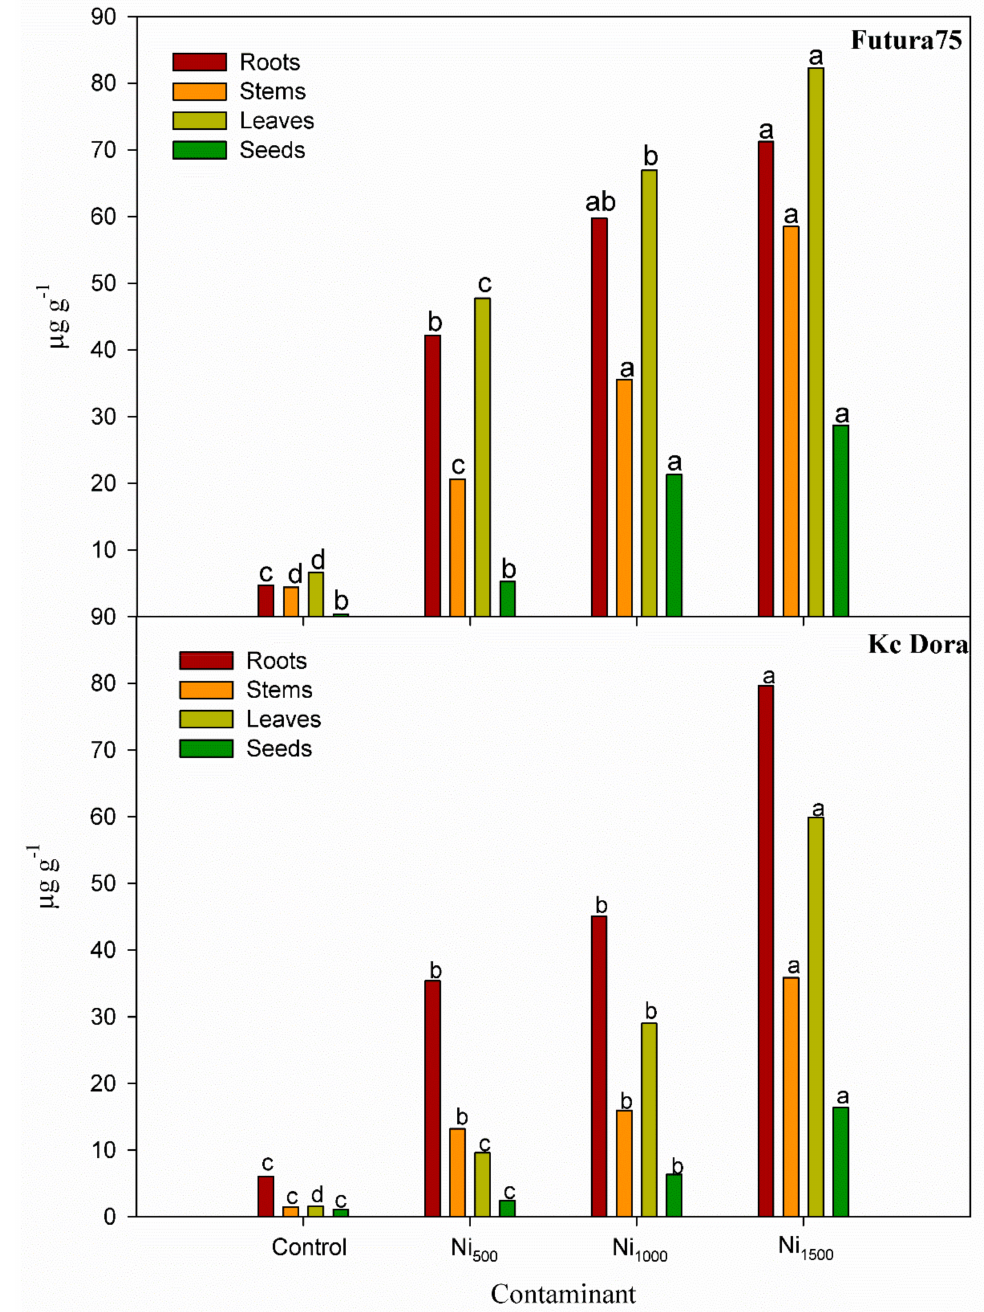
Figure 3. Concentration of nickel ( µ g g − 1 ) in roots, stems, leaves, and seeds in Futura 75 and KC Dora. The comparisons were performed within the plant fractions. Different letters indicate significant differences between the means (according to HSD at p ≤